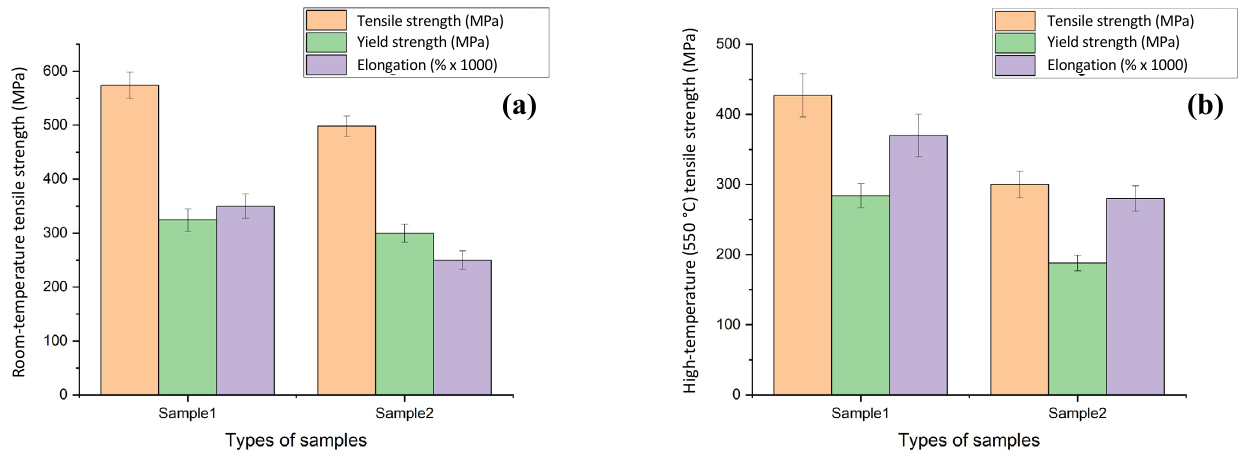
Figure 4. ( a ) Room-temperature tensile test, ( b ) high temperature tensile testing. Figure 4b summarizes the high-temperature (550 °C) tensile performance test results.